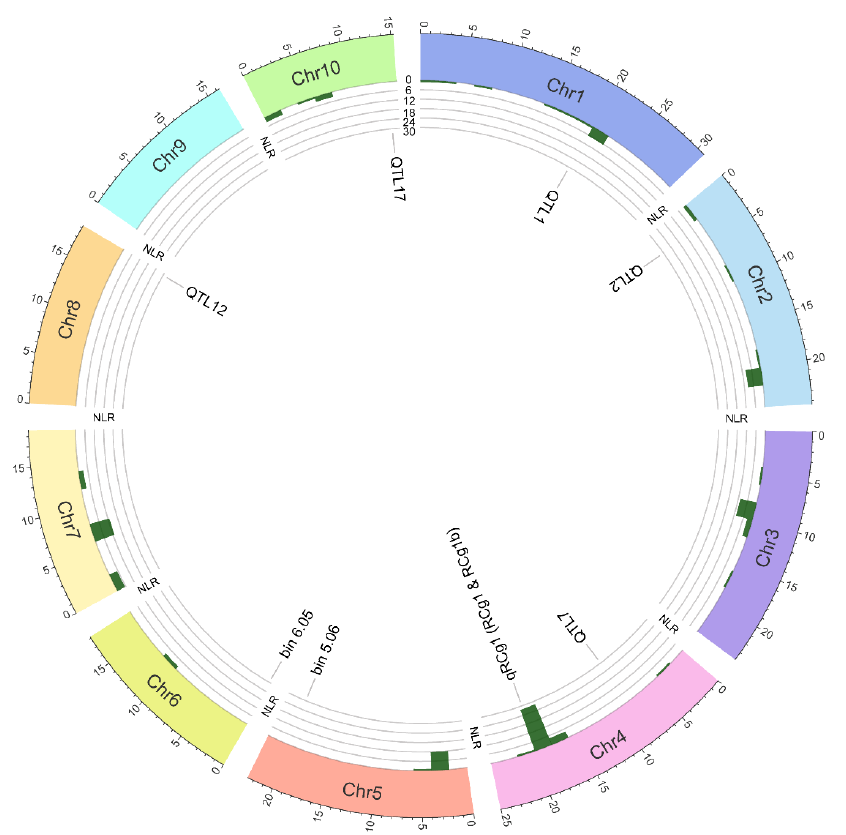
Figure 3. Circos plot exemplifying the distribution of 144 NLRs (encoding nucleotide-binding leucine-rich repeat resistance proteins) and QTL (conferring resistance to anthracnose leaf blight and stalk rot) in the Zea mays B73 genome. The outer track shows the Z. mays ideogram, comprising ten chromosomes (Chr1 through Chr10). The middle track consists of five circular ticks (6 NLRs /tick); the bars inside the track exhibit the frequency distribution of NLRs on the chromosomes. The inner track indicates the location of QTL based on their flanking marker positions listed in Table 1. The B73 genome lacks the QTL qRCg1 controlling resistance to anthracnose stalk rot; hence, its location on the B73 genome is relative to the marker UMC15a.